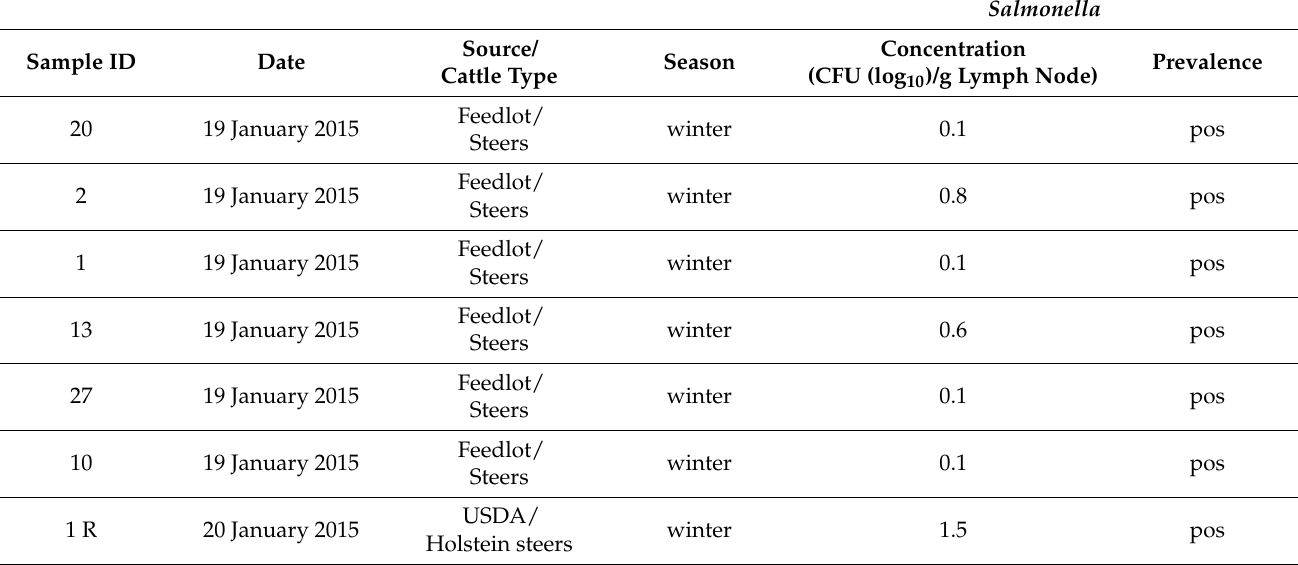
Table 10. Details of peripheral lymph nodes from cattle that were experimentally or naturally infected with Salmonella collected for kinome